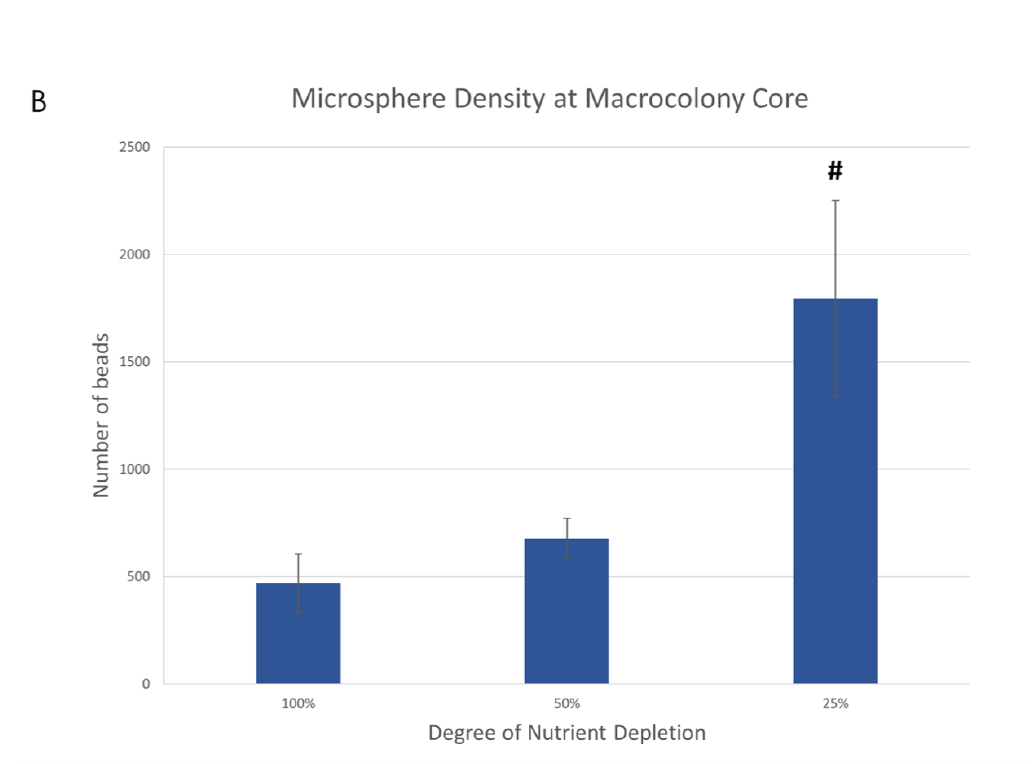
Figure 2. Fluorescent microspheres in mature B. subtilis macrocolonies. ( A ) Core of a mature B. subtilis colony type biofilm (green) grown in a mixture with red microspheres. ( left column, top) 100% nutrient supply, ( right column, top) 25% nutrient supply. Bottom row shows isolated microspheres, corresponding to the top row images. Scale bars 200 µ m. ( B ) Number of microspheres found at macrocolonies’ core at 100%, 50% and 25% nutrient supply. The results are representative of eight experiments. # indicates p <